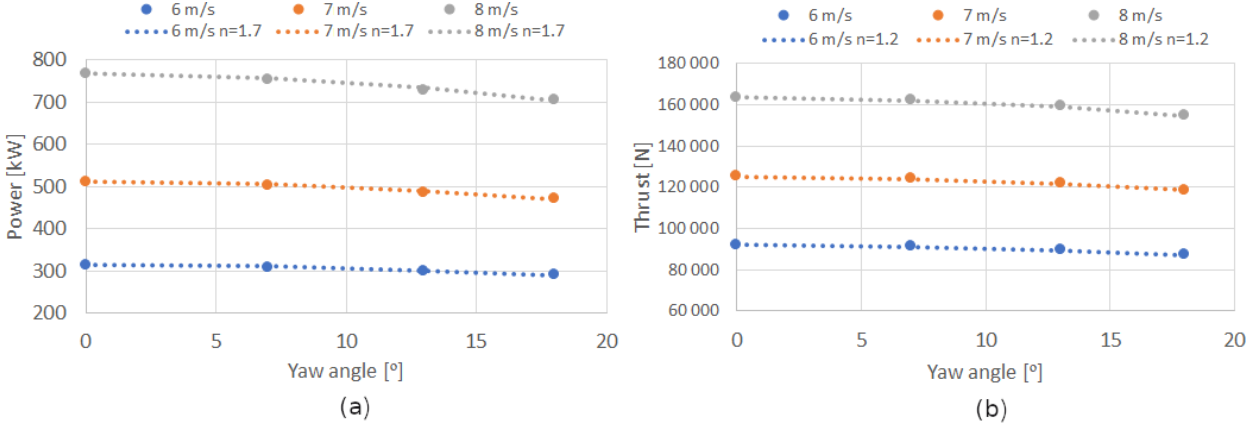
Figure 9. (a) Power and (b) thrust values obtained from data calibration at three wind speed values and at four yaw misalignment settings, compared to a cos( (cid:57) ) n